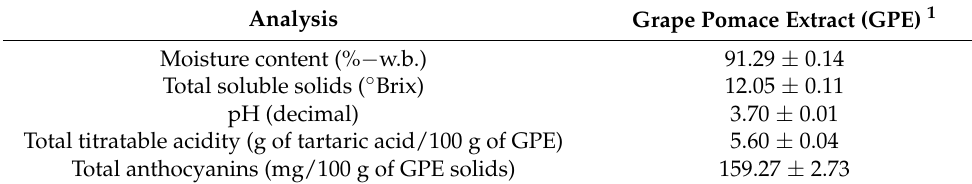
Table 1. Characterization of grape pomace extract (GPE).